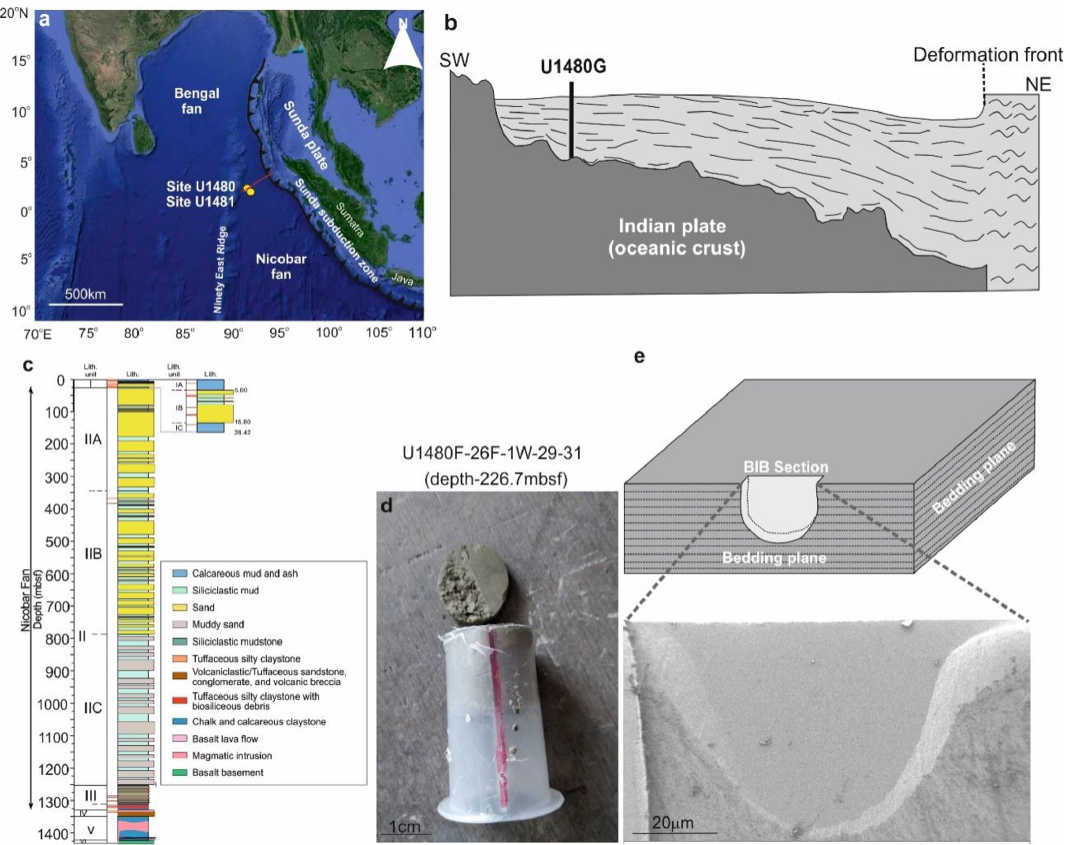
Figure 1. (a) Satellite image of the Sumatra subduction zone and locations of the U1480 and U1481 drilling sites (created from © Google Maps). (b) Schematic diagram showing the location of the primary drilling site and the deepest drill hole (Hole G) at Site U1480 in sectional view (adapted from a seismic profile from SW to NE after Hüpers et al., 2017). The location and extension of the seismic profile are repre- sented by the red line in (a) . (c) Lithostratigraphic units encountered at Site U1480 (adapted after McNeill et al., 2017a). (d) Representative tube sample received from the IODP repository, Japan. The red-colored line on the tube surface represents the notch used to denote the orientation of samples collected from the drill core. (e) Representative BIB cross-section polished perpendicular to the bedding